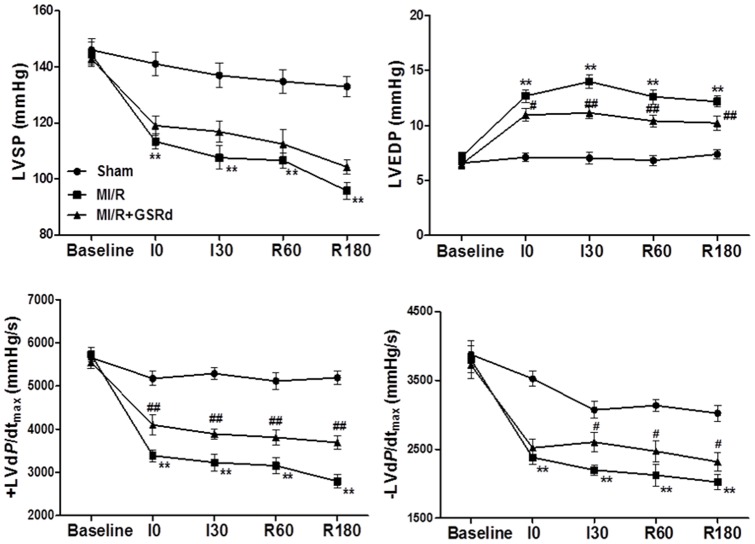
Ginsenoside Rd improves rat cardiac function after 30 minutes ischemia and 3 hours reperfusion.Values presented are mean ± SEM. Abbreviations: LVSP, left ventricular systolic pressure; LVEDP, left ventricular end diastolic pressure; ±LVdP/dt
max, the instantaneous first derivation of left ventricle pressure; MI/R, myocardial ischemia/reperfusion (30 minutes/3 hours). n = 8/group. **P<0.01 vs. Sham, #
P<0.05, ##
P<0.01 vs. MI/R.